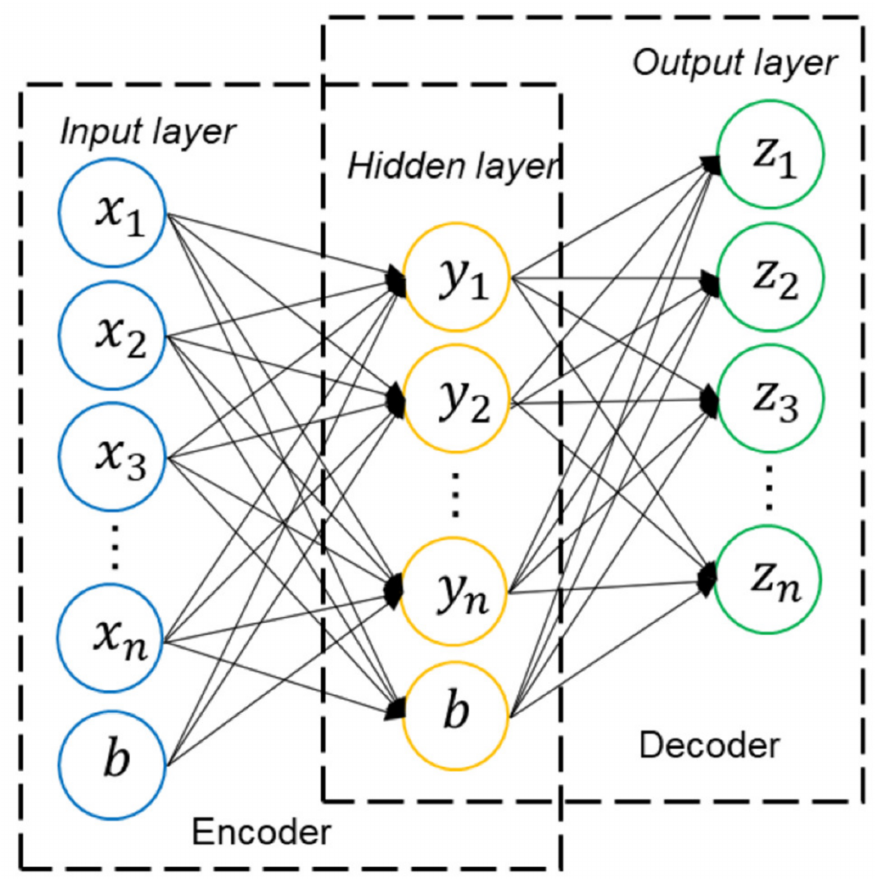
Figure 4. The network structure of